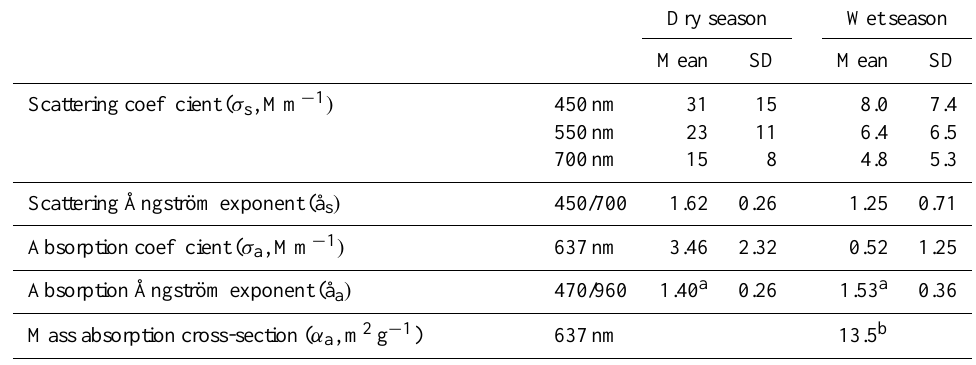
Table 7. Summary of aerosol optical parameters for the dry and wet seasons. Average and standard deviations are calculated from 60min data.